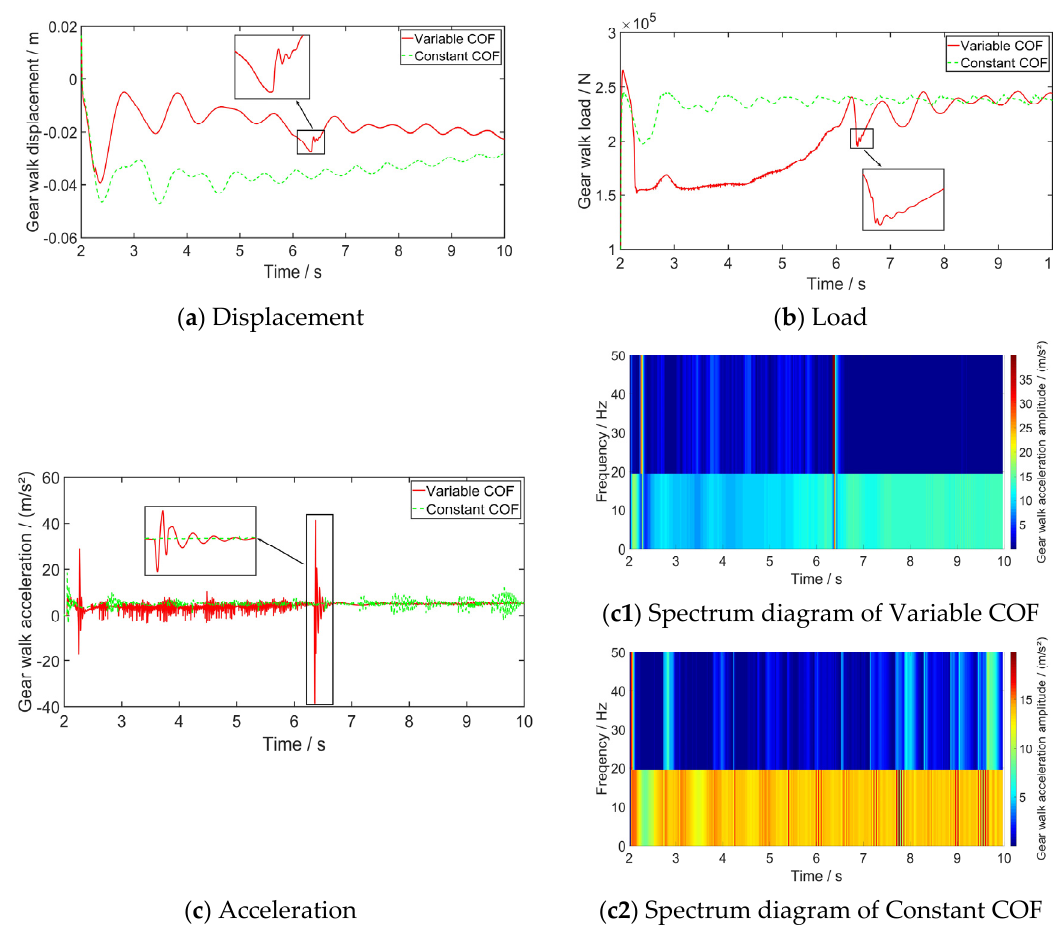
Figure 8. C/SiC brake disc variable friction characteristics’ effect on gear walk.